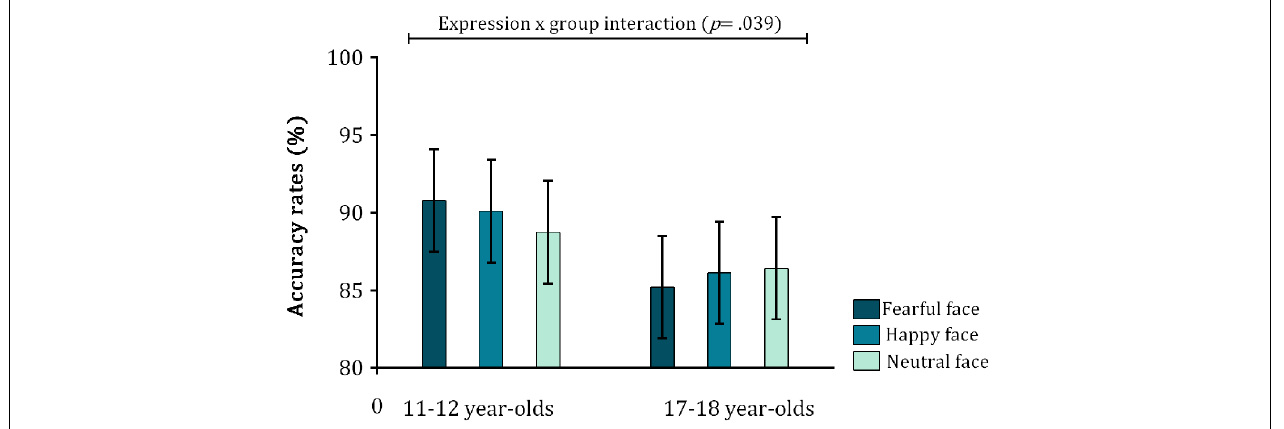
FIGURE 4 | Mean accuracy rates (in percent) for the no-go trials in both age groups. Error bars indicate 1 SE of the mean. None of the main effects of expression within age-group or between age-group differences across emotions were